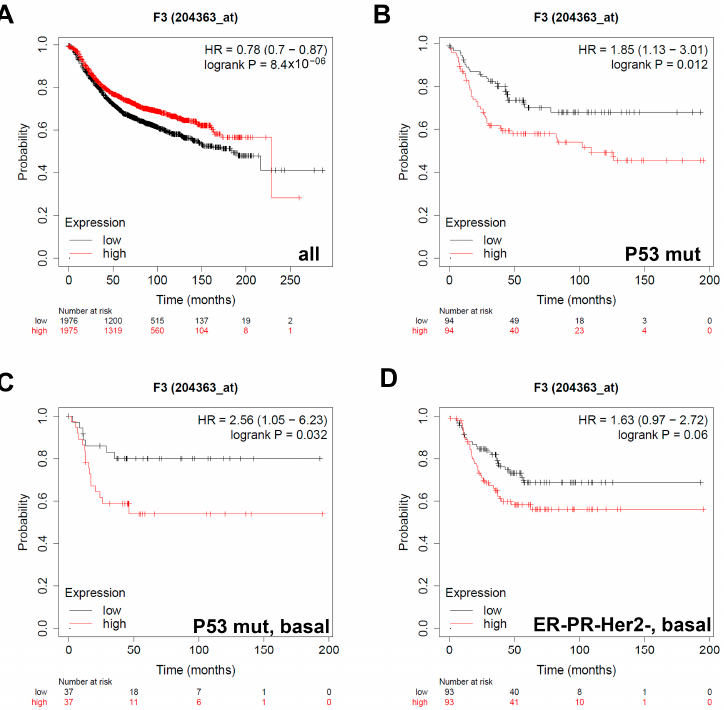
Figure 4. The prognostic value of the expression of F3 in patients with breast cancer. Kaplan–Meier curves are plotted based on the expression of F3 in ( A ) all patients ( n = 3951), ( B ) p53 mutated ( n = 1149), ( C ) patients with the intrinsic molecular classification Basal and p53 mutated ( n = 901), and ( D ) Triple-negative tumors of the basal subtype ( n = 186). Curves were analyzed using the log-rank test. Log-rank p values and hazard ratios are shown. Log-rank p values and hazard ratios (HRs; 95% confidence interval in parentheses) are shown. The corresponding Affymetrix ID is